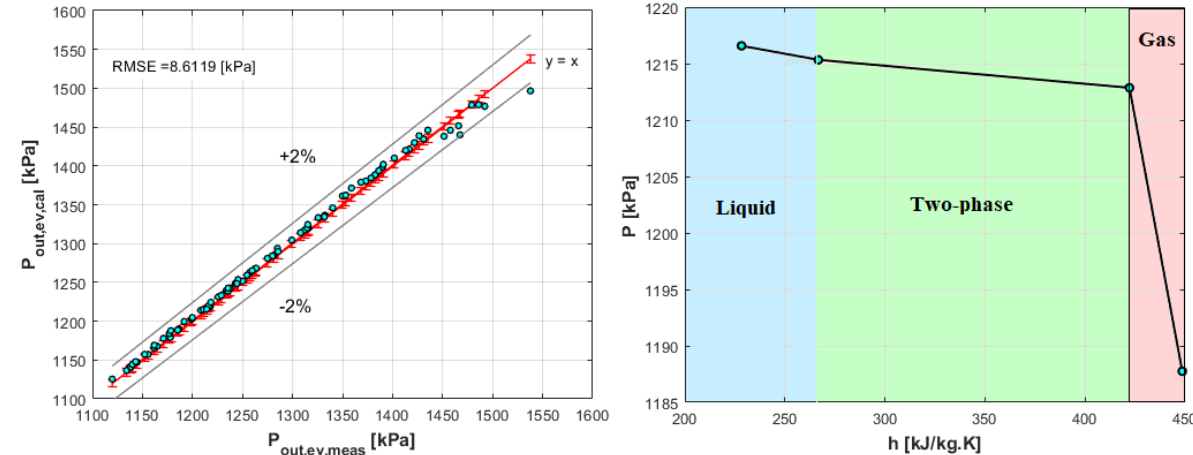
Figure 16. Calculated and measured pressure drop of the condenser ( left ) and pressure drop resolution in different heat transfer zones in the condenser ( right ).